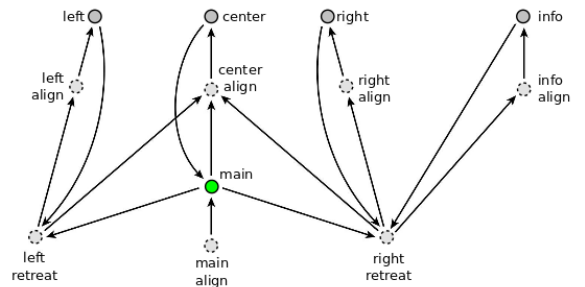
Fig. 5. Connected graph of the movement within an exhibit via its entry pose main and hotspots ( left , center , right , and info ).